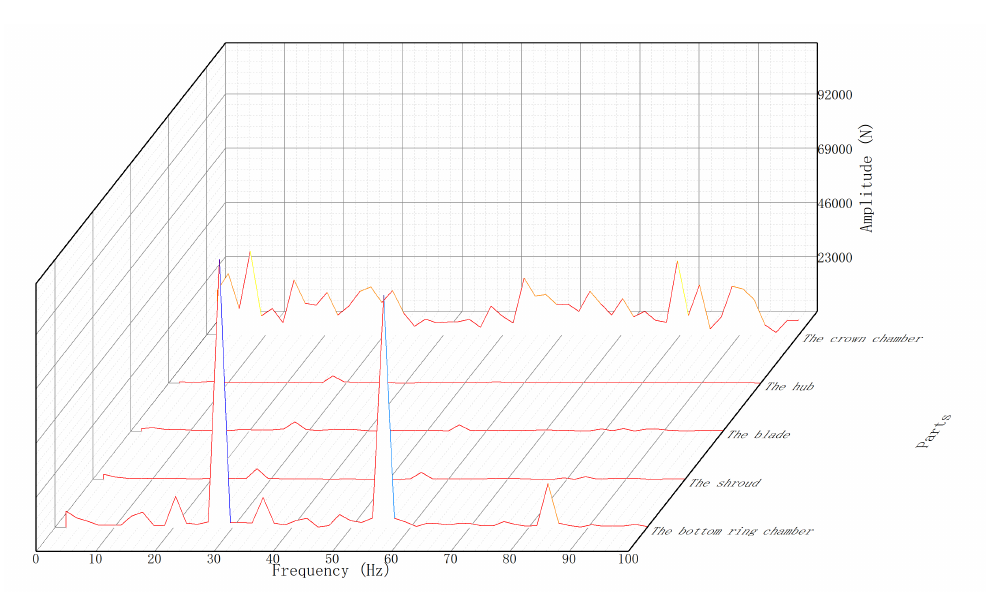
Figure 16. The FFT of the total radial